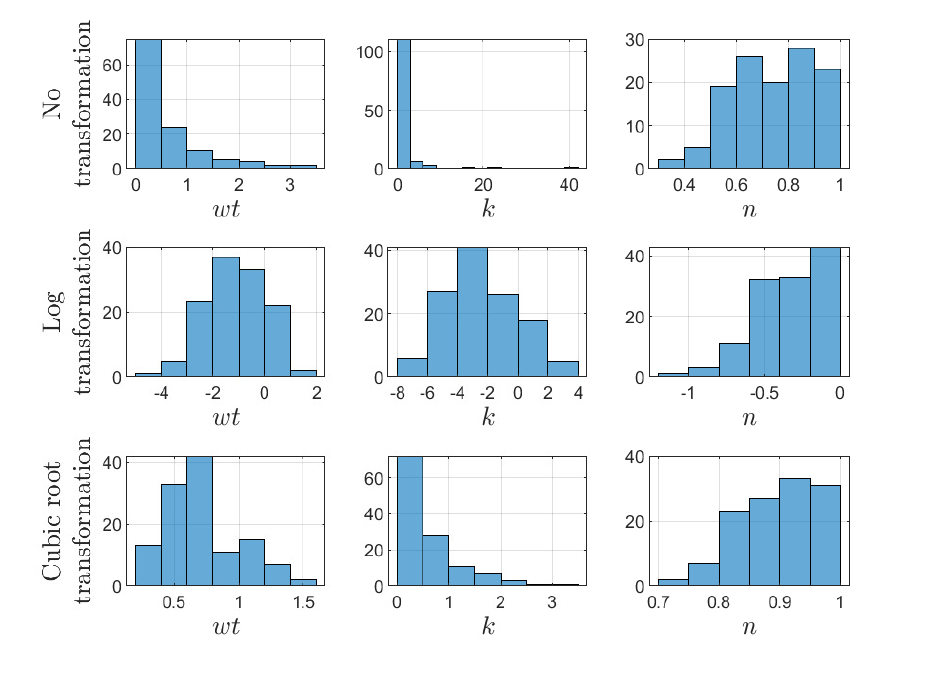
Figure 3. Histograms of wt , k , and n for the CMC records, with logarithm and cubic root